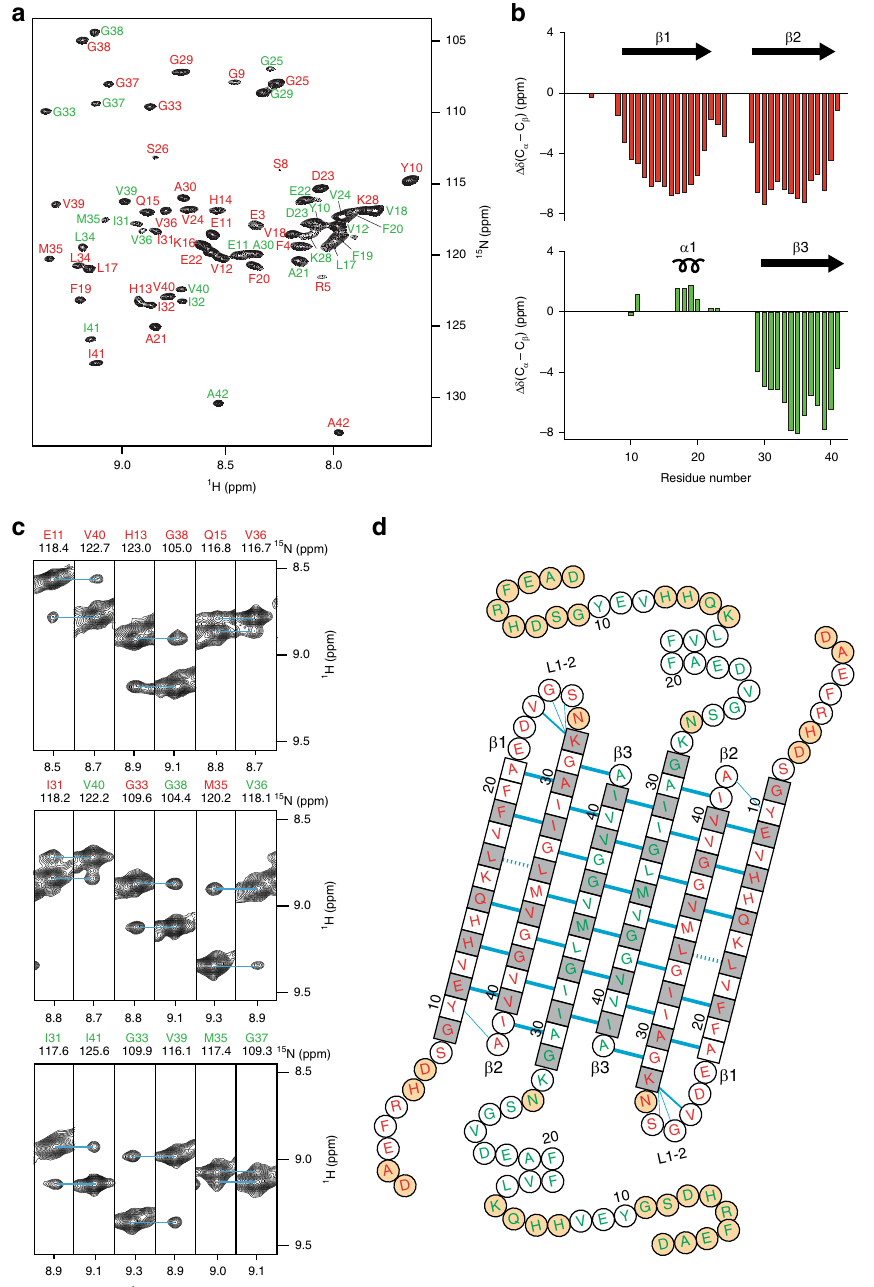
Fig. 1 Architecture of the A β (1-42) tetramer. a Amide resonance assignments of the A β (1-42) tetramer. Two A β (1-42) subunits are detected and residues belonging to each of them are labeled in either red or green. b Three-bond averaged secondary chemical shifts versus residue number for the red (top) and the green (bottom) A β (1-42) subunits. Secondary structural elements derived from chemical shift indices are shown at the top with its corresponding number. Arrows indicate β -strands and helical symbols helices. c Strips from a 3D NH-NH NOESY spectrum de fi ning long-range intra-monomer interactions between the red A β (1-42) subunit, long-range inter-monomer interactions between the red and the green A β (1-42) subunits, and long-range inter-dimer interactions between the two green A β (1-42) subunits. d The amino acid sequence of the A β (1-42) tetramer is arranged on the basis of the secondary and tertiary structure. Amino acids in square denote β -sheet secondary structure as identi fi ed by secondary chemical shifts; all other amino acids are in circles. Blue lines denote experimentally observed NOE contacts between two amide protons. Bold lines indicate strong NOEs typically observed between hydrogen-bonded residues in β -sheets. Dashed lines show probable contacts between protons with degenerate 1 H chemical shifts. The side chains of white and gray residues point towards distinct sides of the β -sheet plane, respectively. Orange circles correspond to residues that could not be assigned. Sample conditions were 1 mM 2 H, 15 N, 13 C A β (1-42) in 10 mM Tris, 28.5 mM DPC at pH 9.0 after incubation for 24 h at 37 °C. Source data are provided as a Source data fi